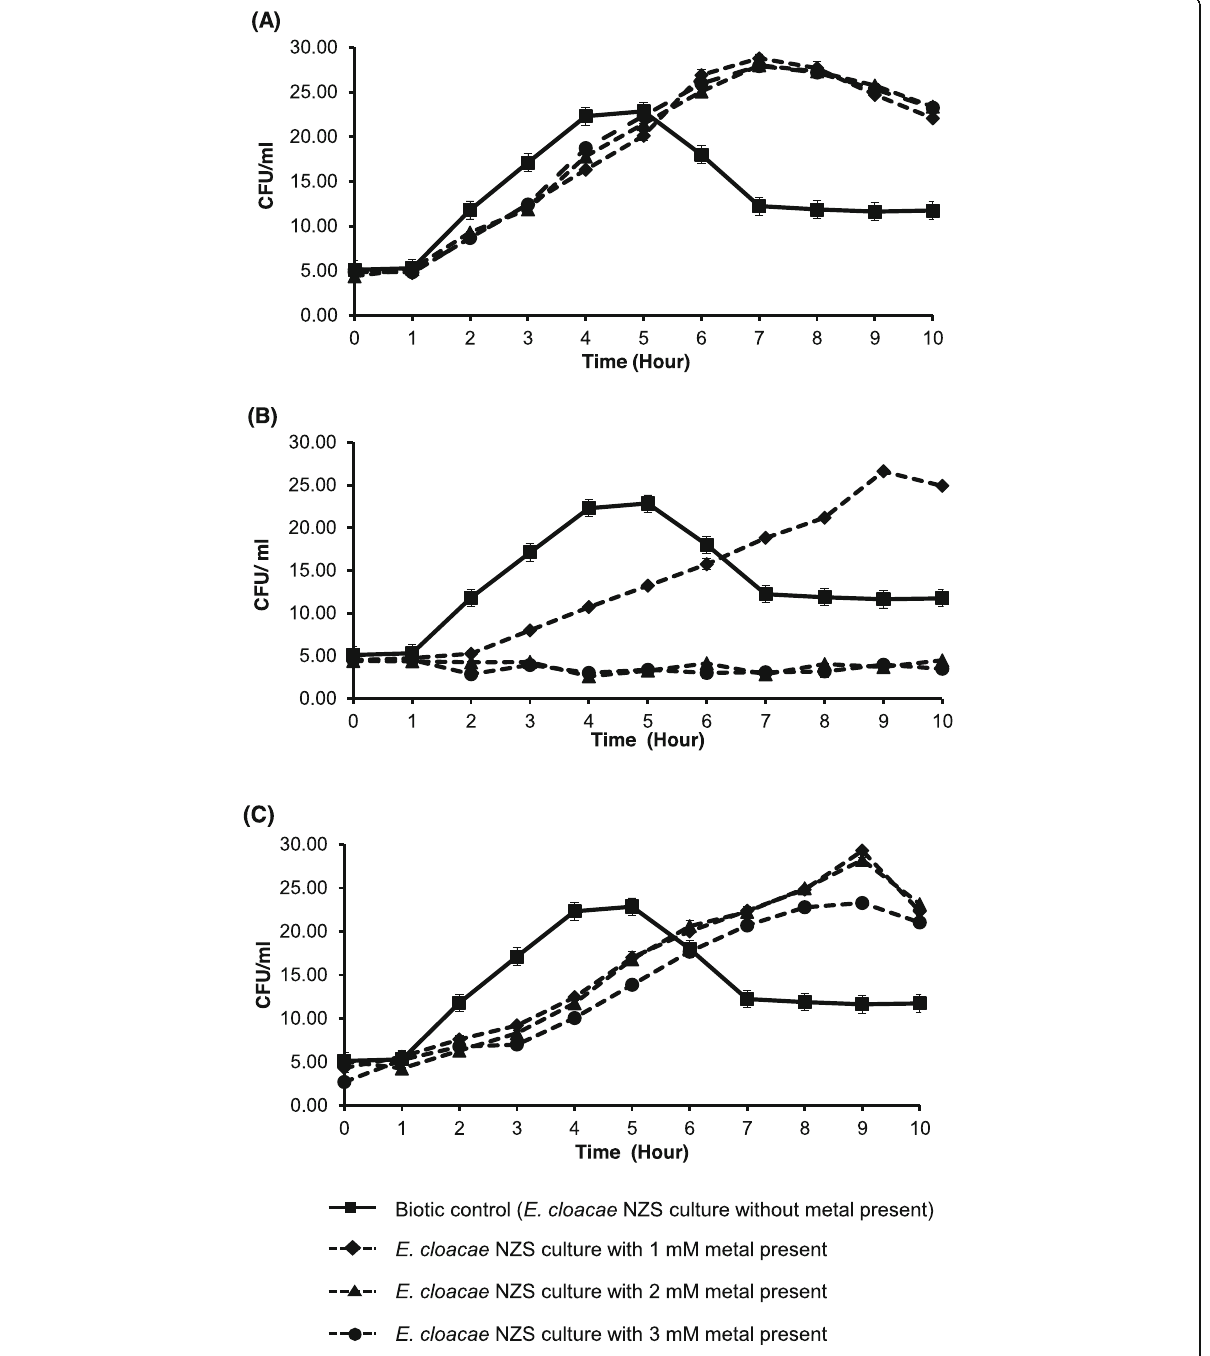
Fig. 2 Growth study of E. cloacae NZS with 0 – 3 mM of a iron (II), b zinc (II), and c copper (II). Cells were cultivated at 37 °C with